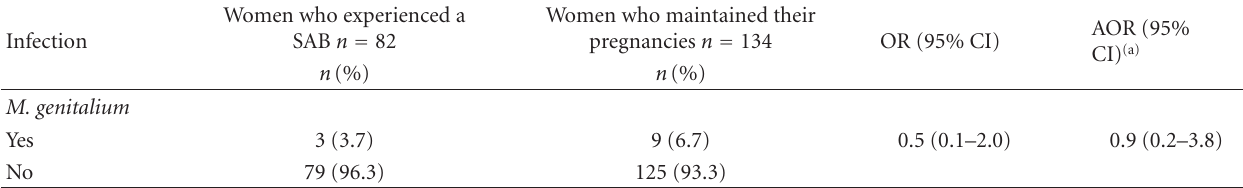
Table 3: Odds of spontaneous abortion according to infection at